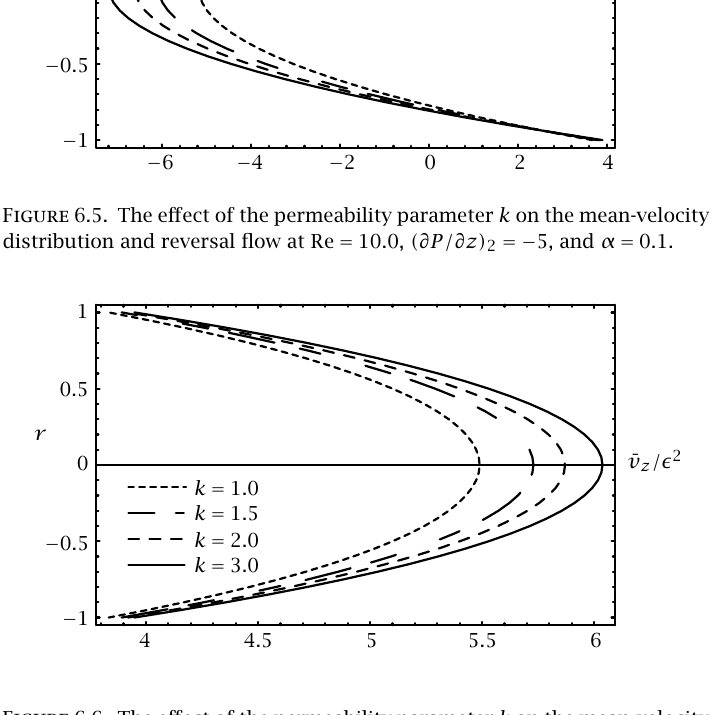
Figure 6.6 . The effect of the permeability parameter k on the mean-velocity distribution and reversal flow at Re = 5 . 0, (∂P/∂z) 2 = 2 . 0, and α = 0 .